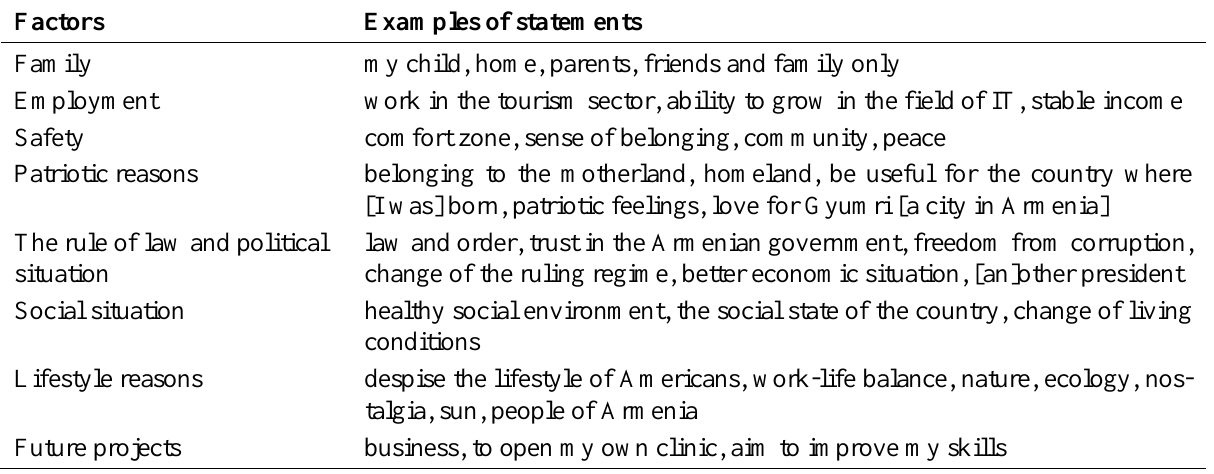
Table 2. Reasons relating to return among migrants (survey results)